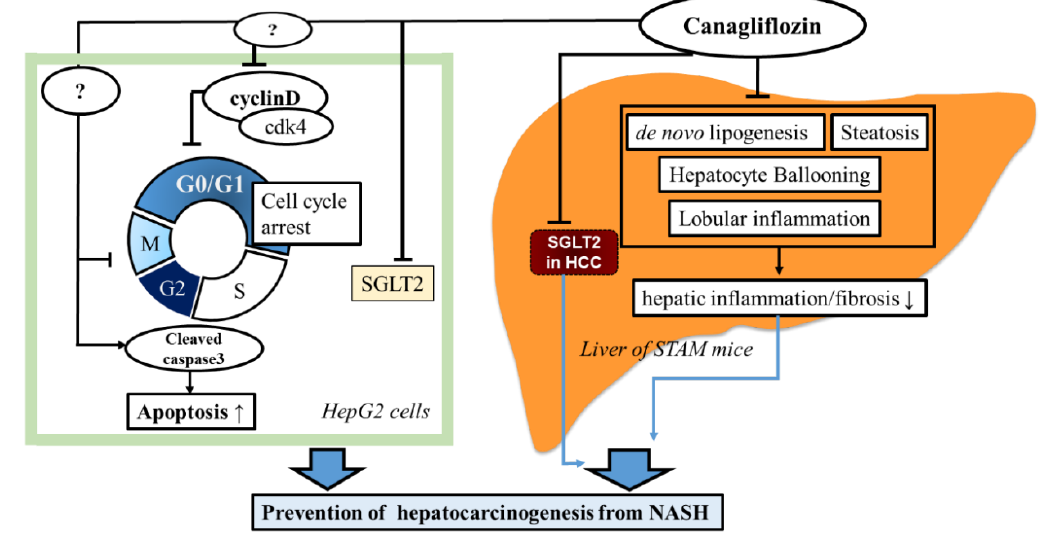
Figure 9. Possible mechanisms responsible for the inhibitory effects of canagliflozin on the progression of hepatocarinogenesis from NASH or NAFLD.